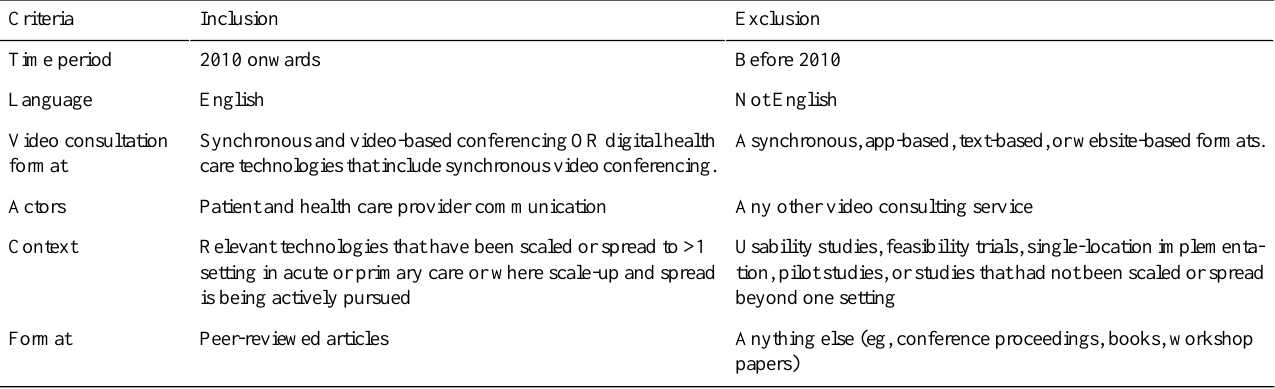
Table 1. Inclusion and exclusion